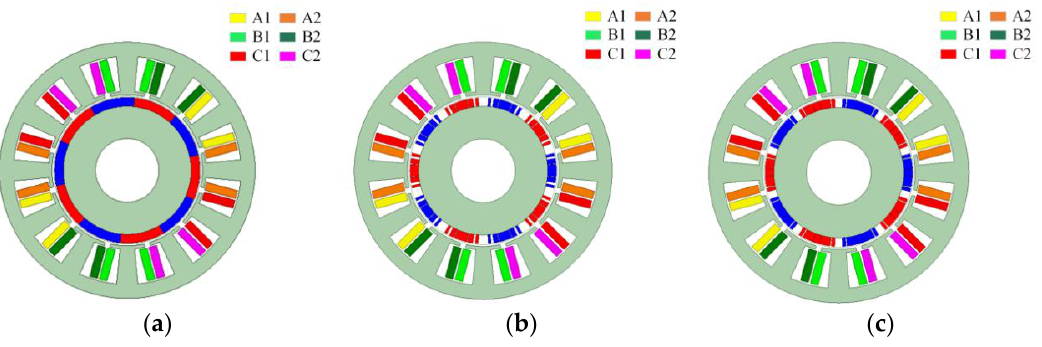
Figure 8. FEA model of motor with different magnetic pole structures: ( a ) conventional surface- mounted PM shape; ( b ) equivalent sinusoidal PM shape; ( c ) equivalent sin + 3rd PM shape.